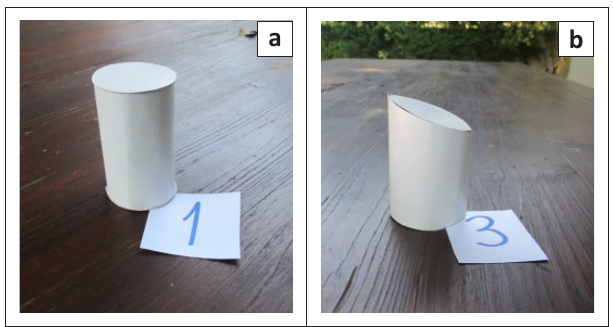
FIGURE 1: An example (a) and a non-example (b) of a cylinder.